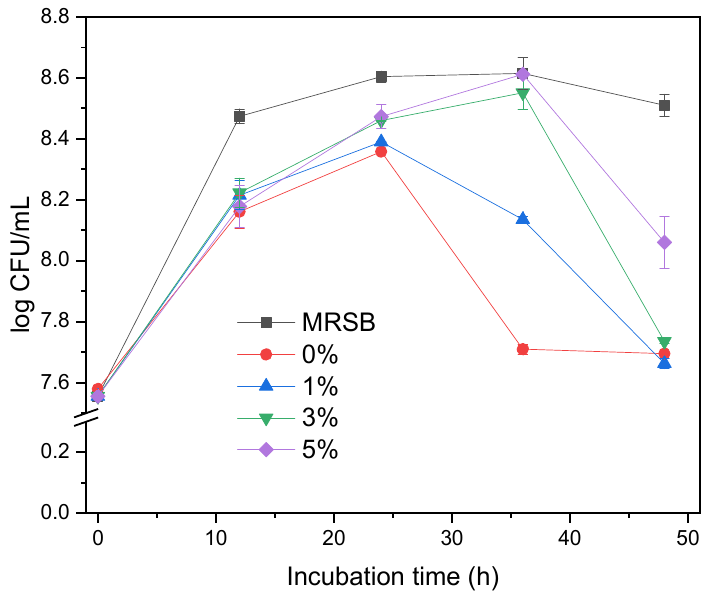
Figure 3. Growth Curve of Lactobacillus acidophilus in MRSB and MRSm media with different concentration of XOS as a function of incubation time.